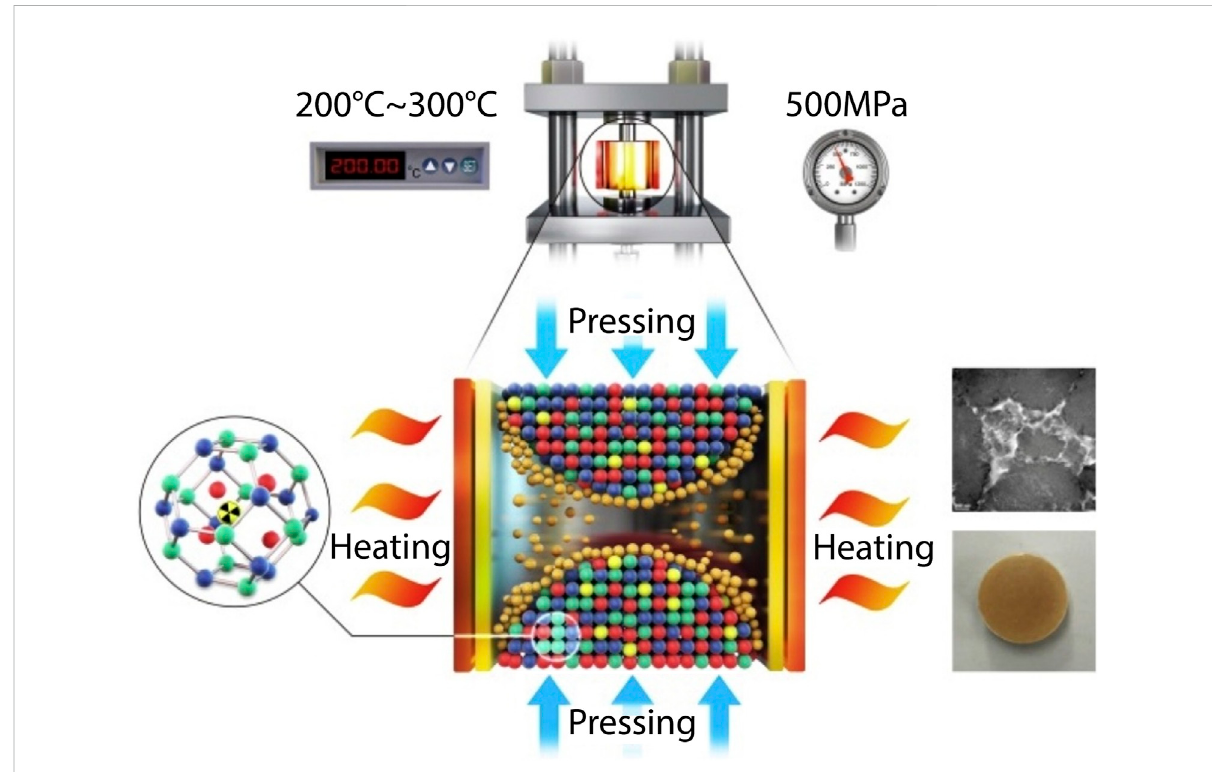
FIGURE 6 Schematic of cold sintering process to consolidate iodosodalite (Hassan et al.,